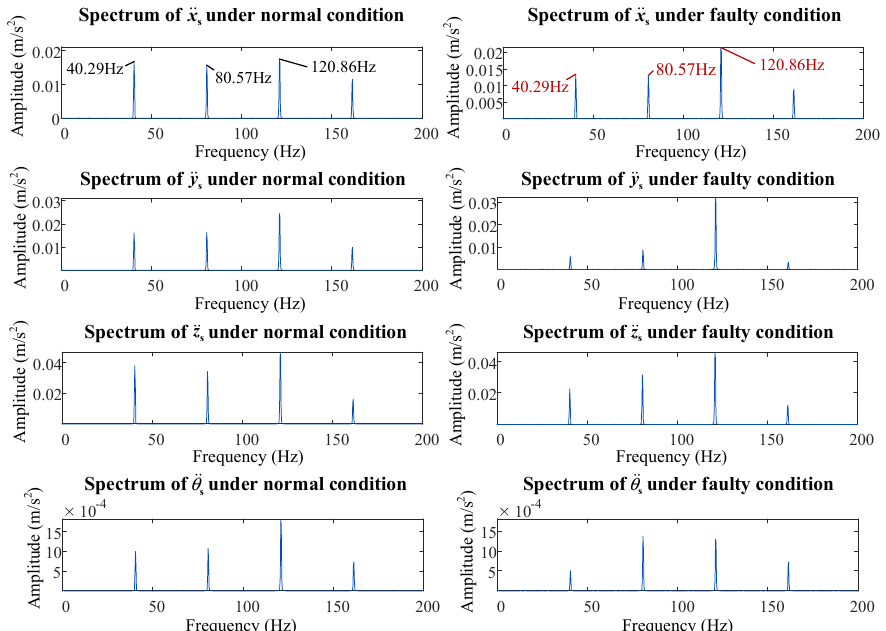
Figure 12. Frequency spectra of the screw shaft related parameters under normal and faulty condi- tions.